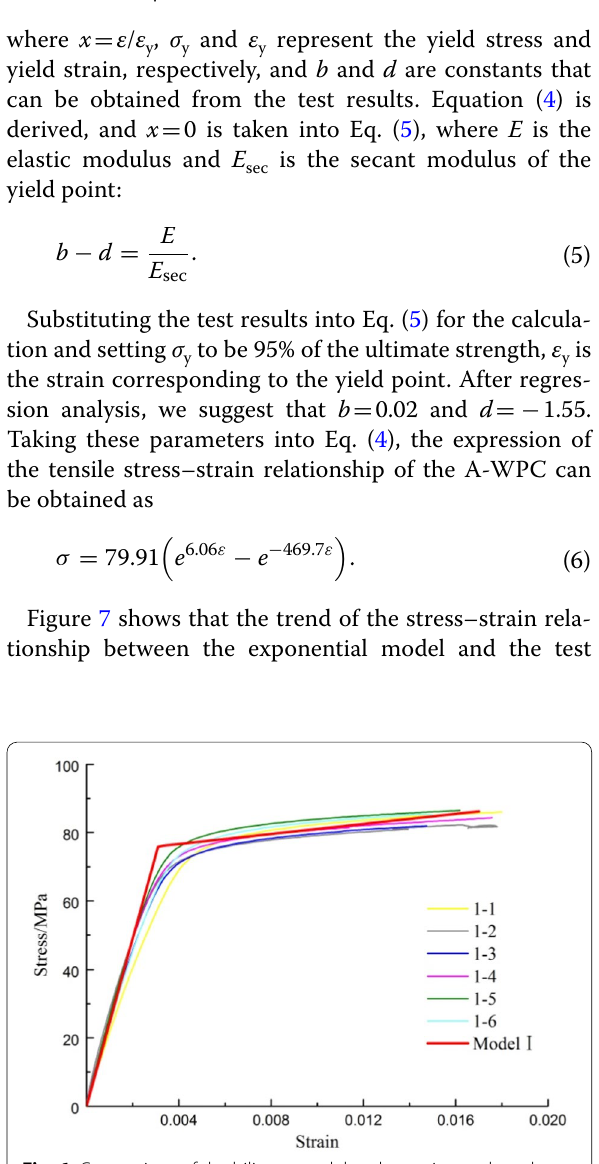
Fig. 8 Tensile and springback process of the